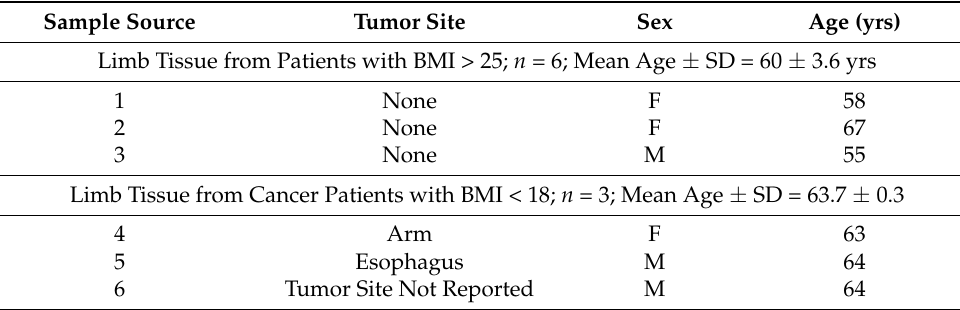
Table 2. Human subjects providing samples for